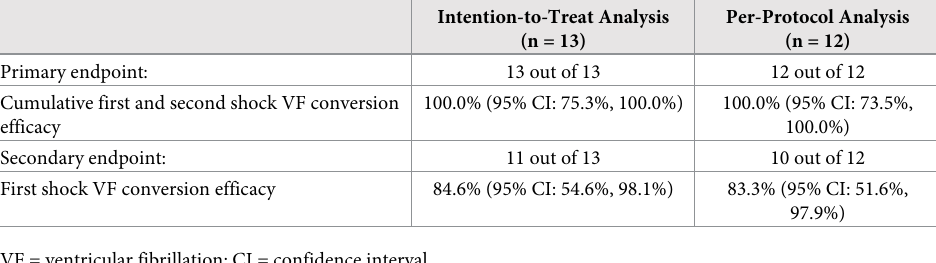
Table 7. Human study defibrillation